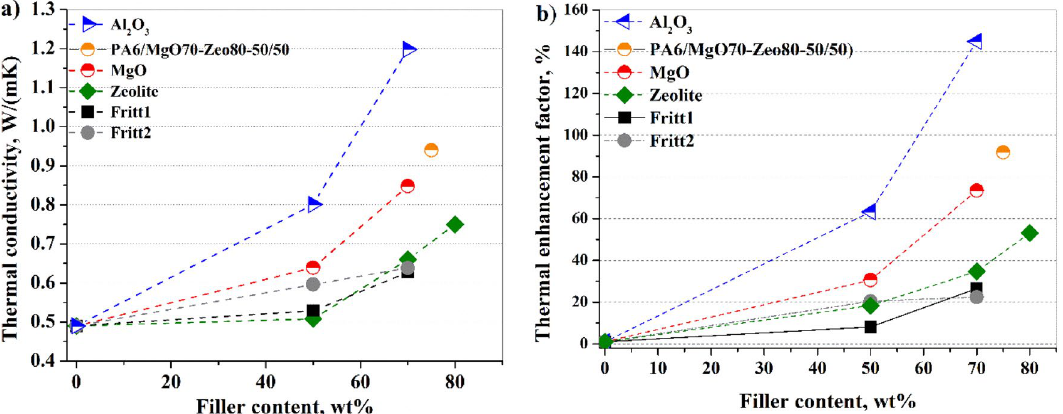
Figure 6. Thermal conductivity ( a ) of the composites with different filler types and weight fractions and thermal enhancement factor ( b ) of different types of